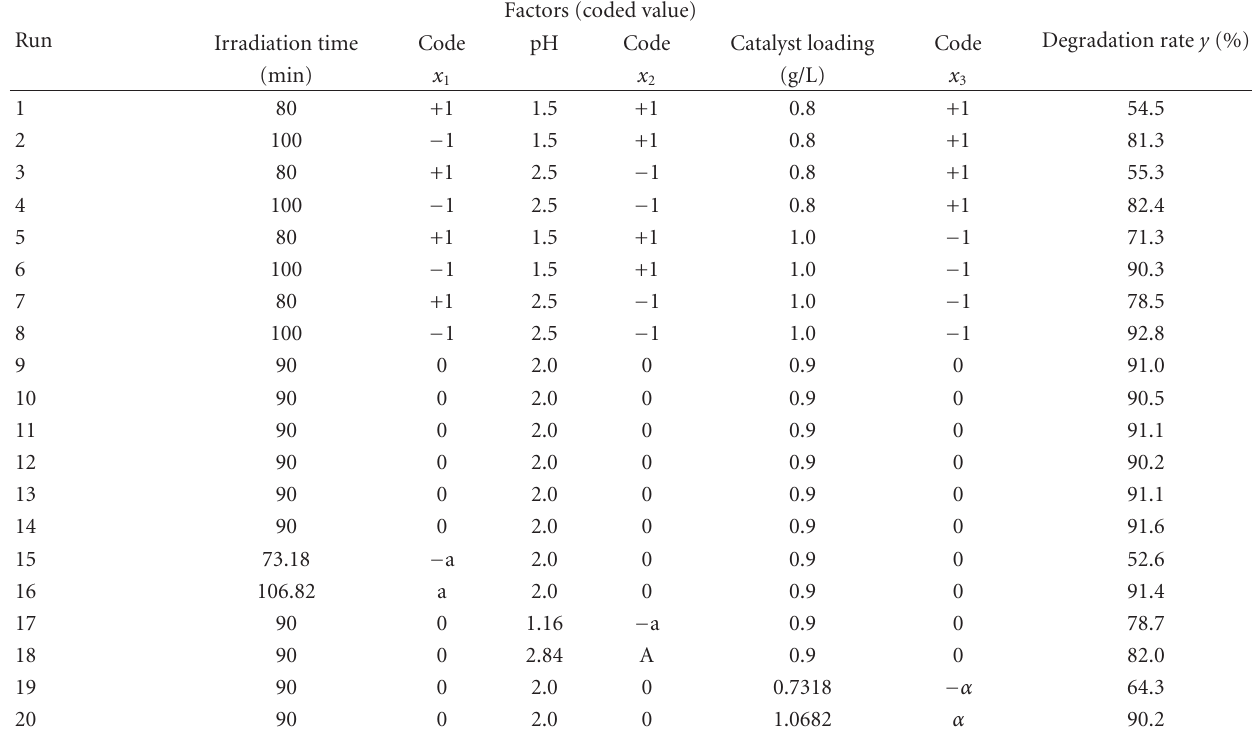
Table 2: The central composite experimental design with three independent variables and results.